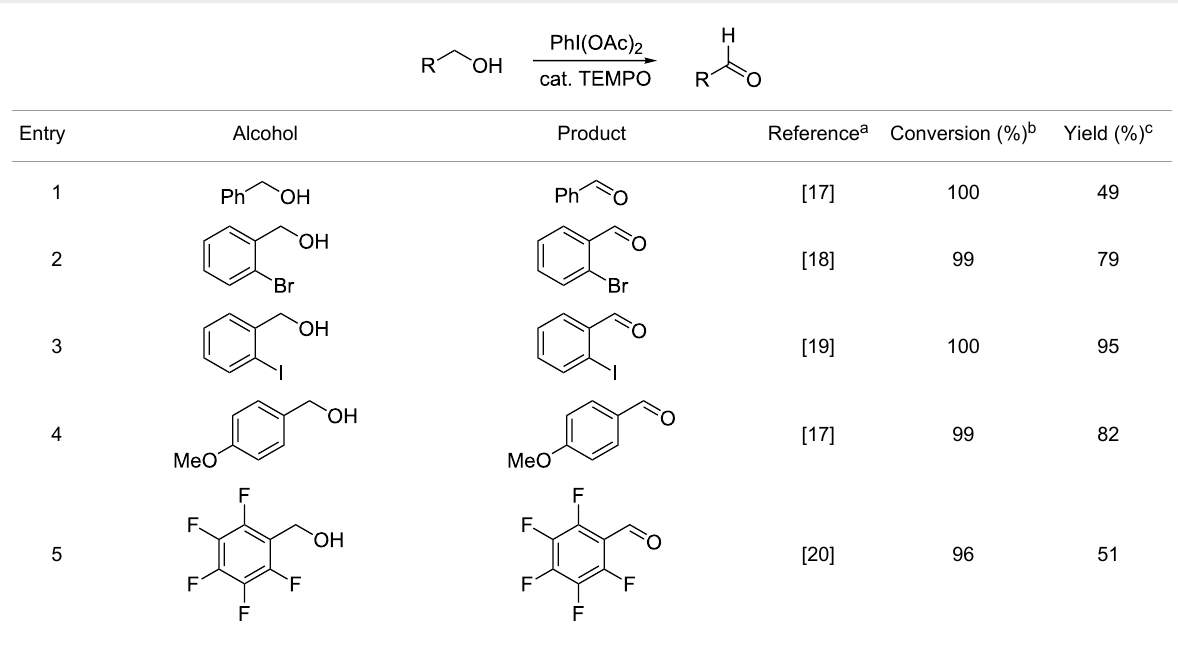
Table 1: Products and yields in the oxidation of alcohols performed in a tubing reactor at a total flow rate of 0.4 mL/min (residence time: 4.5 min) at 35 °C.